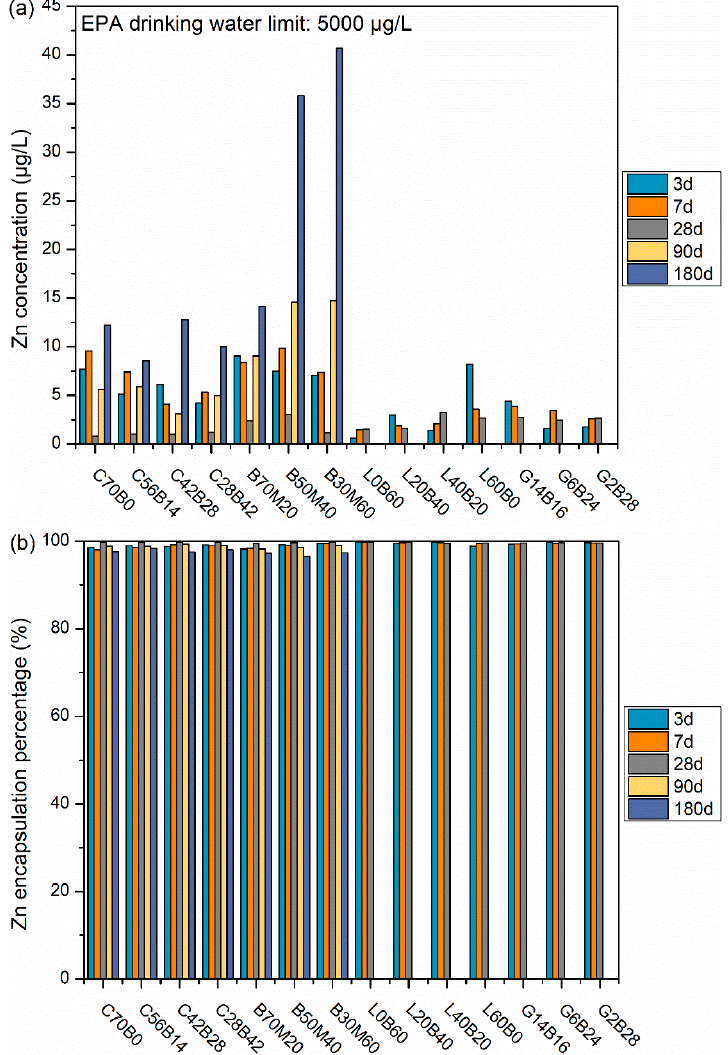
Figure 7. The ( a ) Zn concentration and ( b ) encapsulation percentage for the leachate in all groups at all ages. all